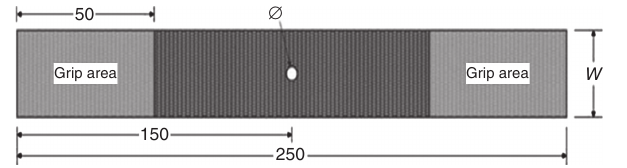
Figure 5 Typical OHT specimen with dimension.